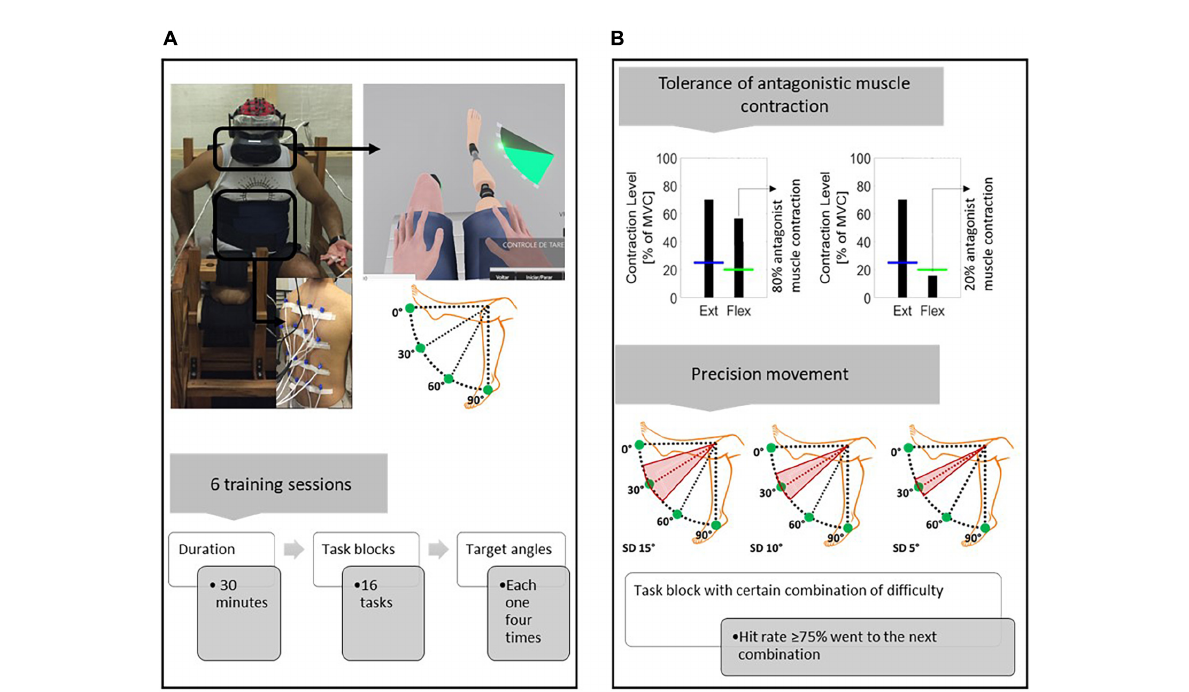
FIGURE2 Training protocol with the EMG-based HMI scheme. (A) Training protocol diagram. Feedback within the virtual environment consisted of visual clues indicating the target angles that the participants had to reproduce. The target angles used were 0 ◦ , 30 ◦ , 60 ◦ , and 90 ◦ . Each angle was randomly presented four times during each task block (the participant had 20 s to establish each target angle). In addition to visual feedback, the participants received concomitant vibrotactile feedback on their back. The training sessions lasted 30 mins, and within that time, as many task blocks as possible were performed. (B) Difficulty of progression. Two criteria were adopted to increase the difficulty: (i) Tolerance of antagonist muscle contraction. Initially, the antagonist muscle could have up to 80% activation in comparison to the agonist muscle. The tolerance decreased progressively by 10% at each new difficulty level (the lower the tolerance was, the greater the need to isolate the agonist muscle contraction). (ii) Precision movement. To evaluate whether a target angle has been reached, different ranges of prosthesis position, in relation to the target angle, were adopted (15 ◦ , 10 ◦ , and 5 ◦ : the lower the range was, the greater the necessary precision of movement). Given a tolerance of antagonist muscle contraction, the different precision difficulties were progressively combined. If the participant had a success rate ≥ 75% on a task block with a certain combination of difficulties, the next block instituted a new combination of